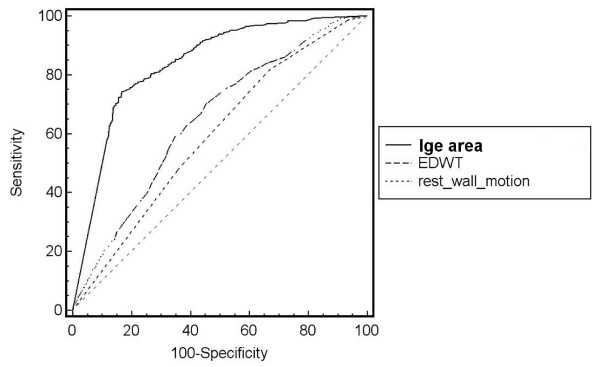
Comparison of ROC curves for the prediction of wall motion improvement by LGE area, end-diastolic wall thickness and resting wall motion.